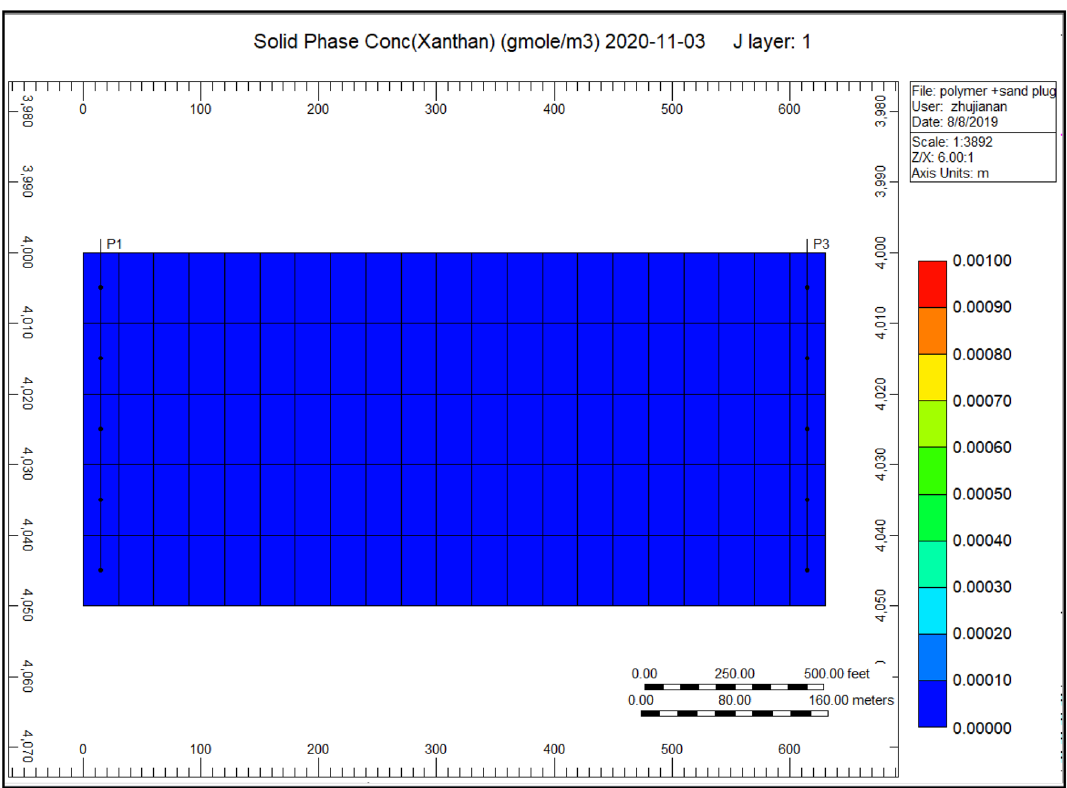
Figure 11. Indicates the cross-linked gel solid-phase concentration in the direction of the production well CMG STARS 2017.10 URL: https:// www. cmgl. Figure 12 indicates the porosity rise of the cross-linked gel performance model, the porosity at the place of an injection well alongside an increasing portion of 0.2277800. However, at the position of the producer well decreased to a range of 0.227782. Comparing to Fig. 6 shows the porosity reduction during the polymer sand plug model, the porosity was improved.